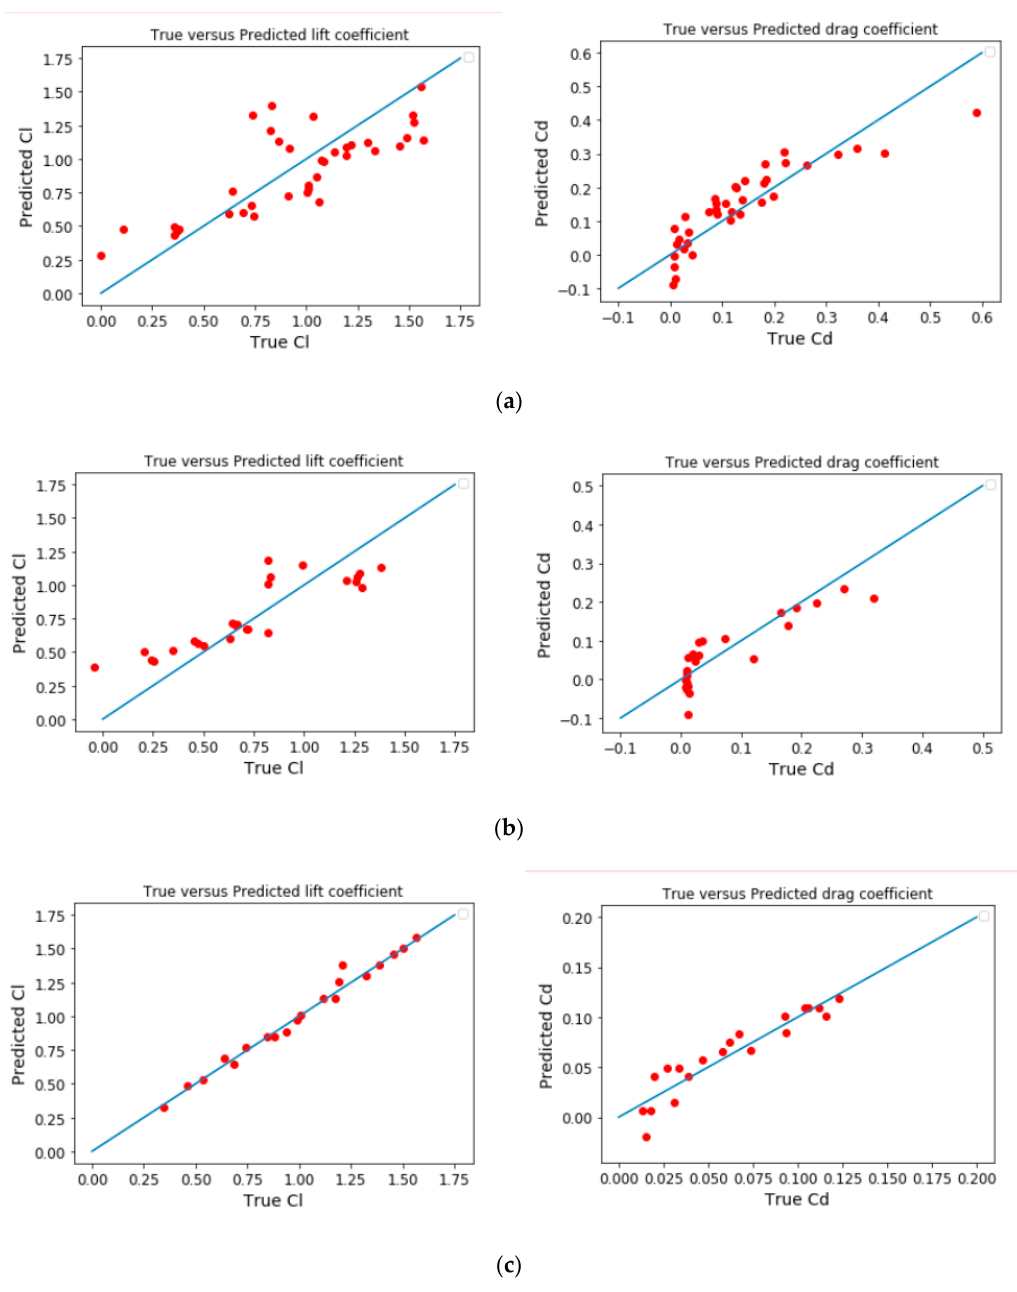
Figure 9. True vs. predicted coefficient values with linear regression method: NACA0012 ( a ) RAE2822 ( b ) and DPW ( c ) databases (left: lift coefficient, right: drag coefficient). Table 10. Performance metrics for the SVR model (MAE: mean absolute error, MSE: mean squared error, R 2 : coe ffi cient of